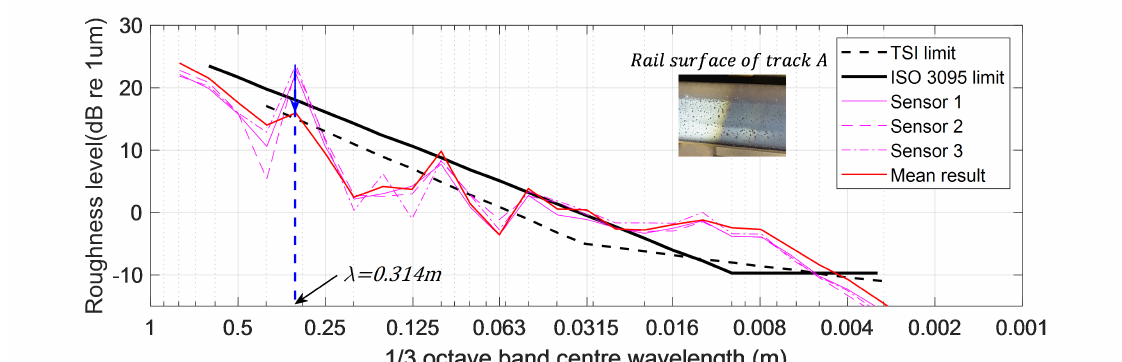
Figure 16. Spectral analysis of Track A railhead